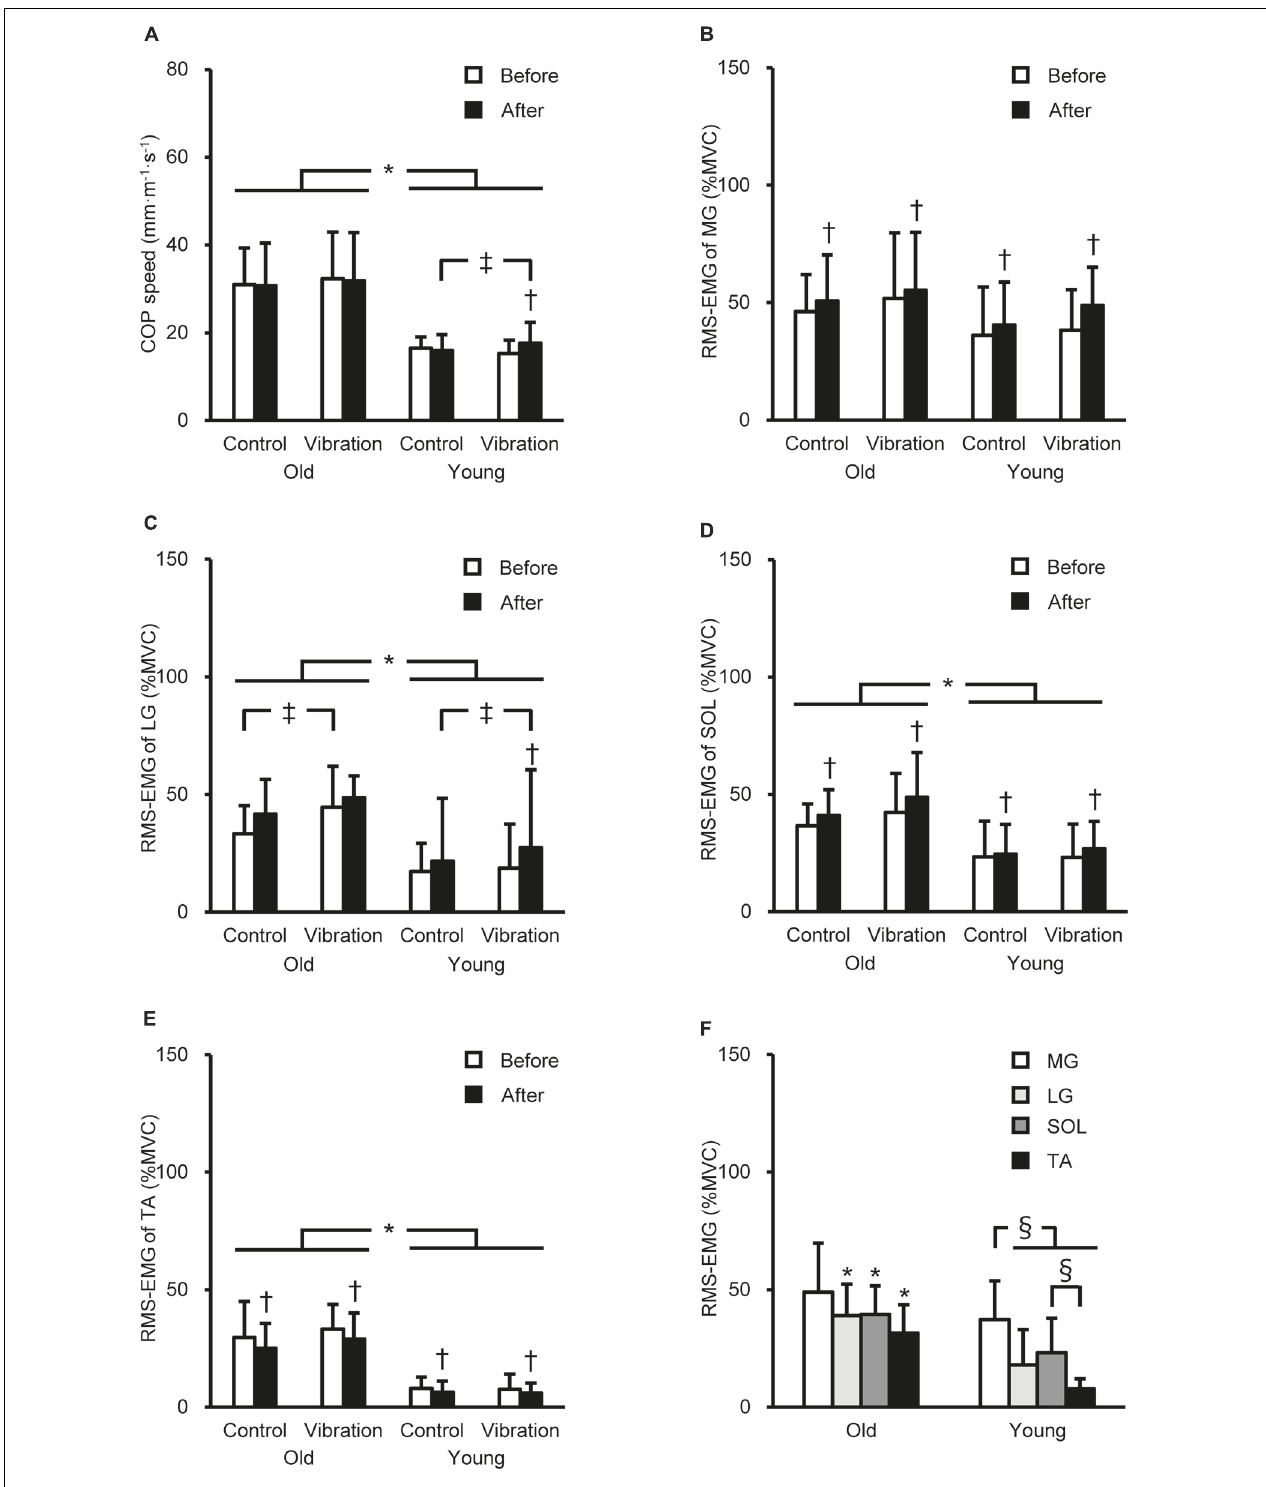
FIGURE 3 | Center of pressure (COP) speed (A) and root mean square of the electromyogram (RMS-EMG) of the medial gastrocnemius (MG, B ), lateral gastrocnemius (LG, C ), soleus (SOL, D ), and tibialis anterior (TA, E ) during single-leg standing before and after the intervention, and RMS-EMGs before the intervention (means of the control and vibration conditions, F ). RMS-EMGs were normalized to those during maximal voluntary contraction (MVC) as agonist (%MVC). *Indicates a significant difference between older and young men. † Denotes a significant change after the intervention. ‡ Shows a significant difference between control and vibration conditions. §Demonstrates a significant difference between